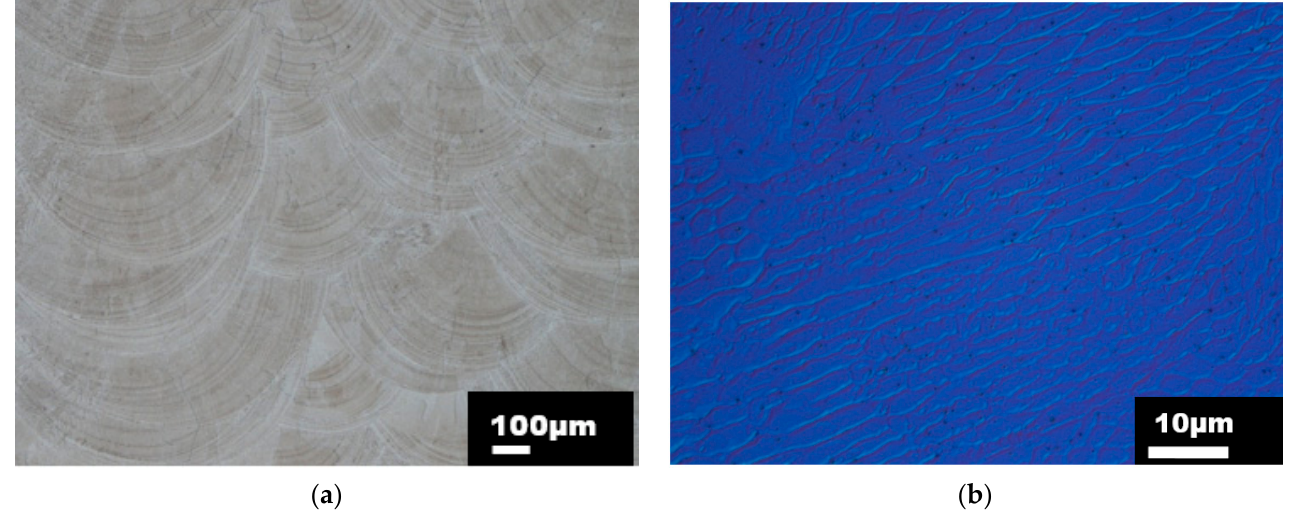
Figure 6. ( a ) Light micrograph of a melt pool path captured in ZX plane (parallel to build direction), ( b ) Light micrograph with differential interference contrast (DIC) captured in ZX plane (higher magnification).